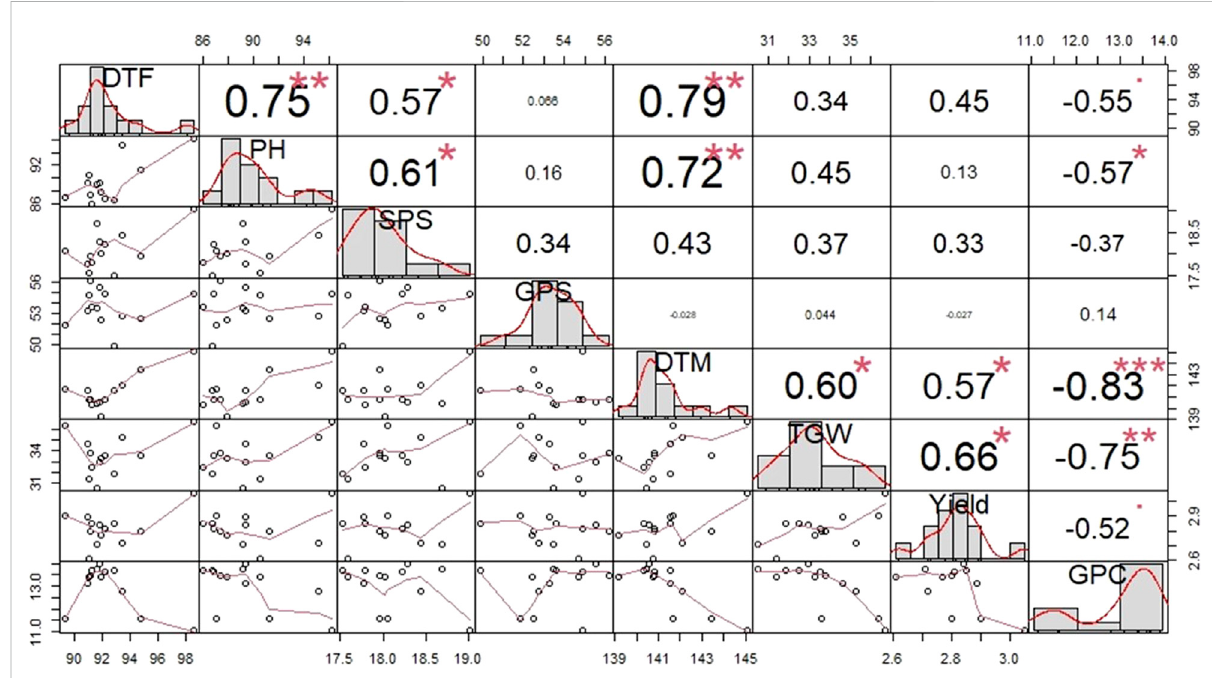
FIGURE 1 Pattern of correlation and level of signi fi cance observed among different traits across all the environments in 13 bread wheat genotypes. DTF, Numberofdaysto fl owering;PH,Plantheight;SPS,Numberofspikeletsperspike;GPS,Numberofgrainperspike;DTM,Numberofdaystomaturity; TGW, 1000-grain weight; GPC, Grain protein